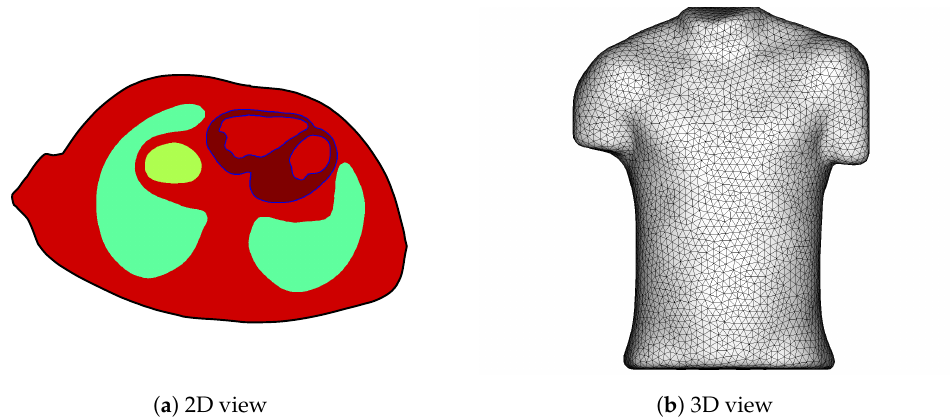
Figure 9. Examples of ECGI-oriented segmentations and mesh generation. ( a ): A 2D cross-section view of a segmented geometry showing the heart (dark red), lungs (green), liver (yellow) and the remaining tissue (red). ( b ): A 3D mesh of a torso volume.